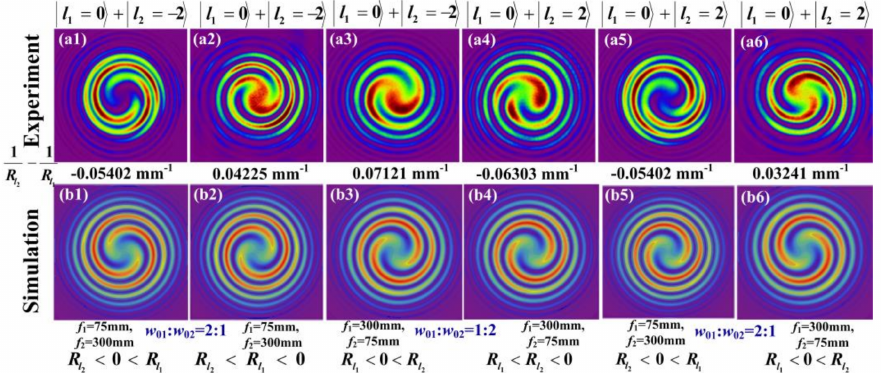
Figure 5. Interferograms of a focused TEM 00 Gaussian beam and a focused vortex beam ( | l 2 = ± 2 (cid:105) ) with different wavefront curvature radii; ( a1 – a6 ) the experimentally measured spiral pattern; ( b1 – b6 ) the numerical